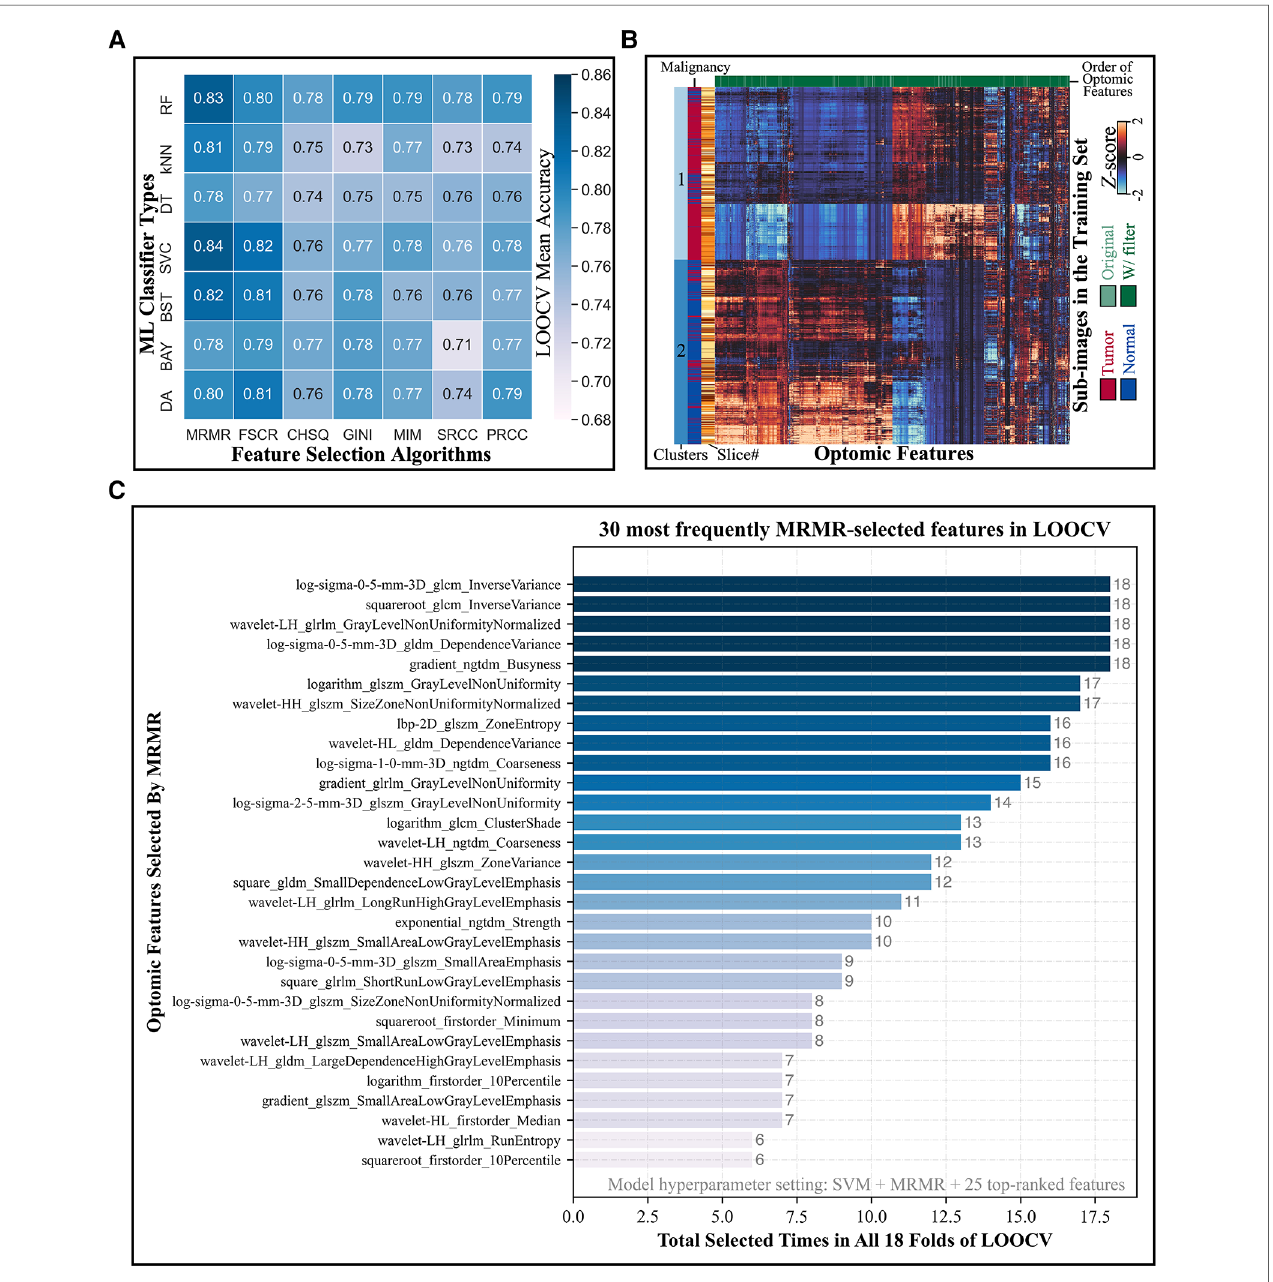
algorithm, and 25 top-ranked features, which provided a LOOCV mean accuracy of 84% ±